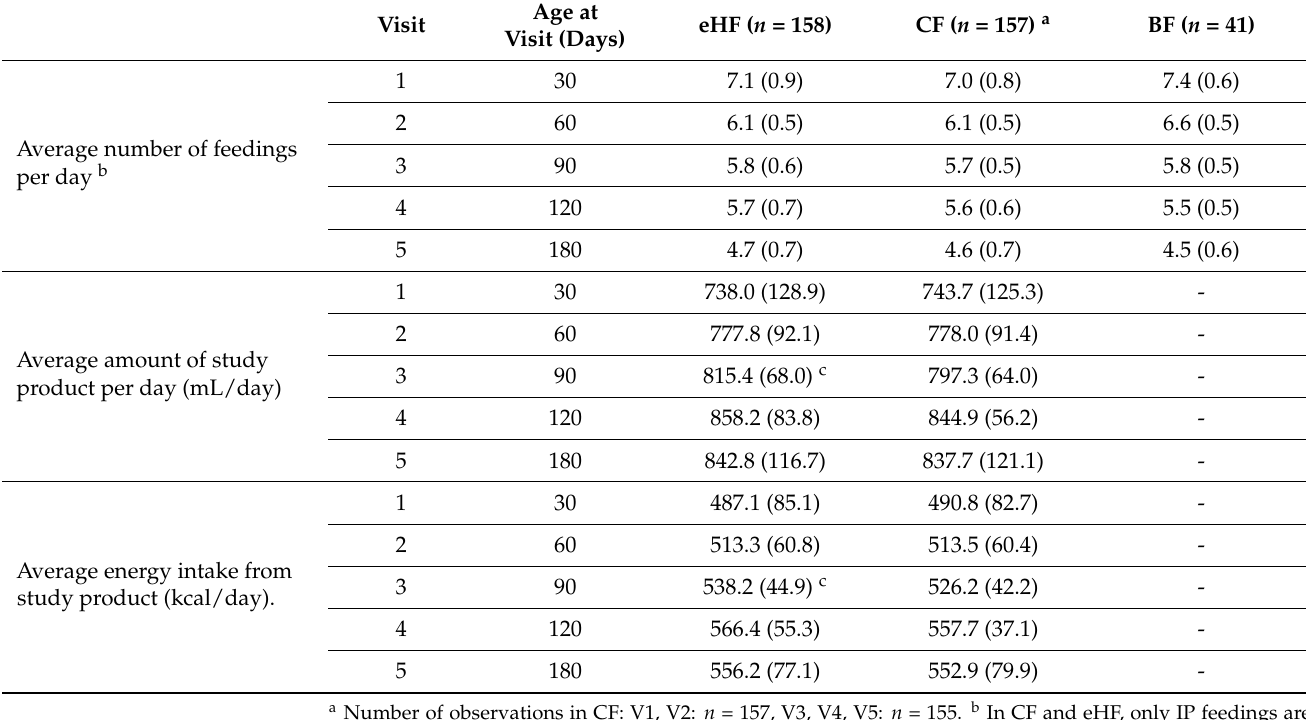
Table 4. Feedings characteristics (FAS), mean